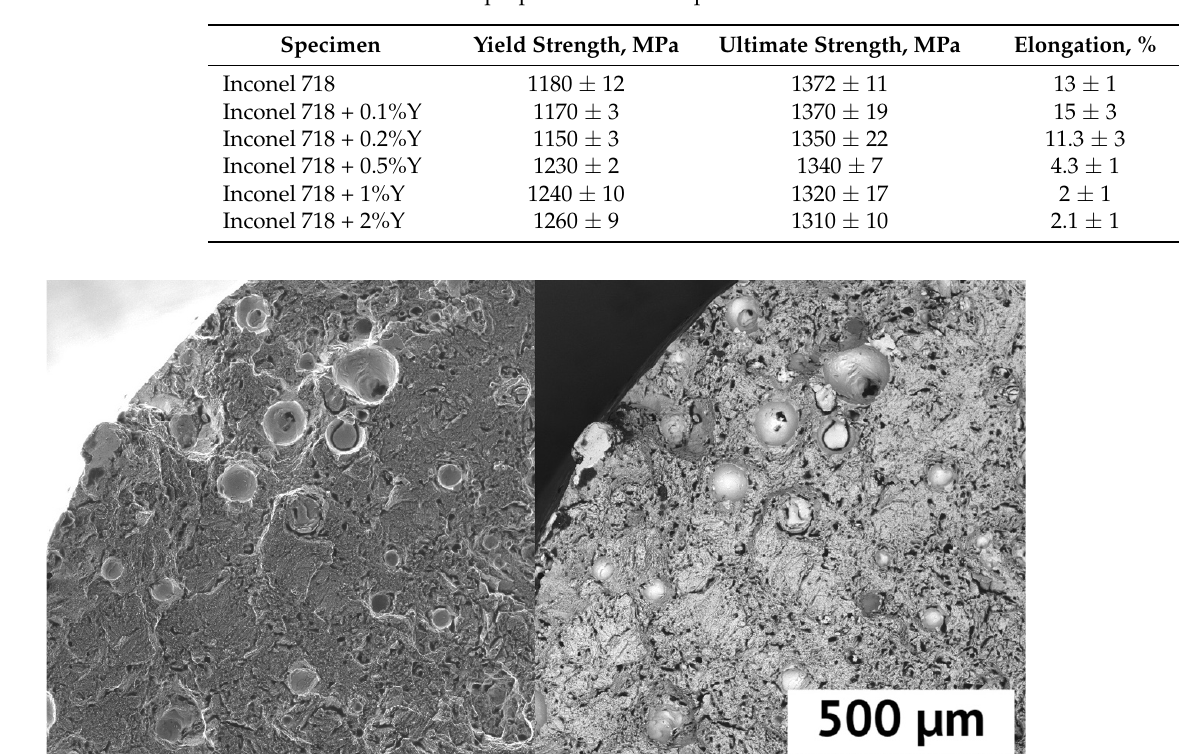
Table 3. Tensile mechanical properties of the samples. Specimen